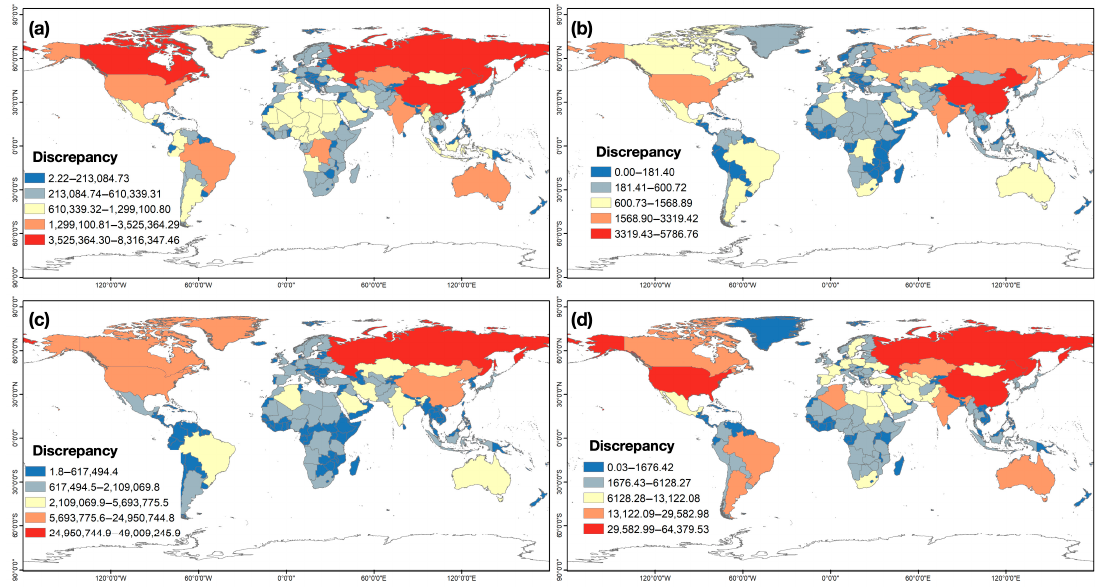
Figure 2 Figure 1. Air pollution discrepancies between two time periods, i.e., from 23 January 2019 to 31 May 2019 and from